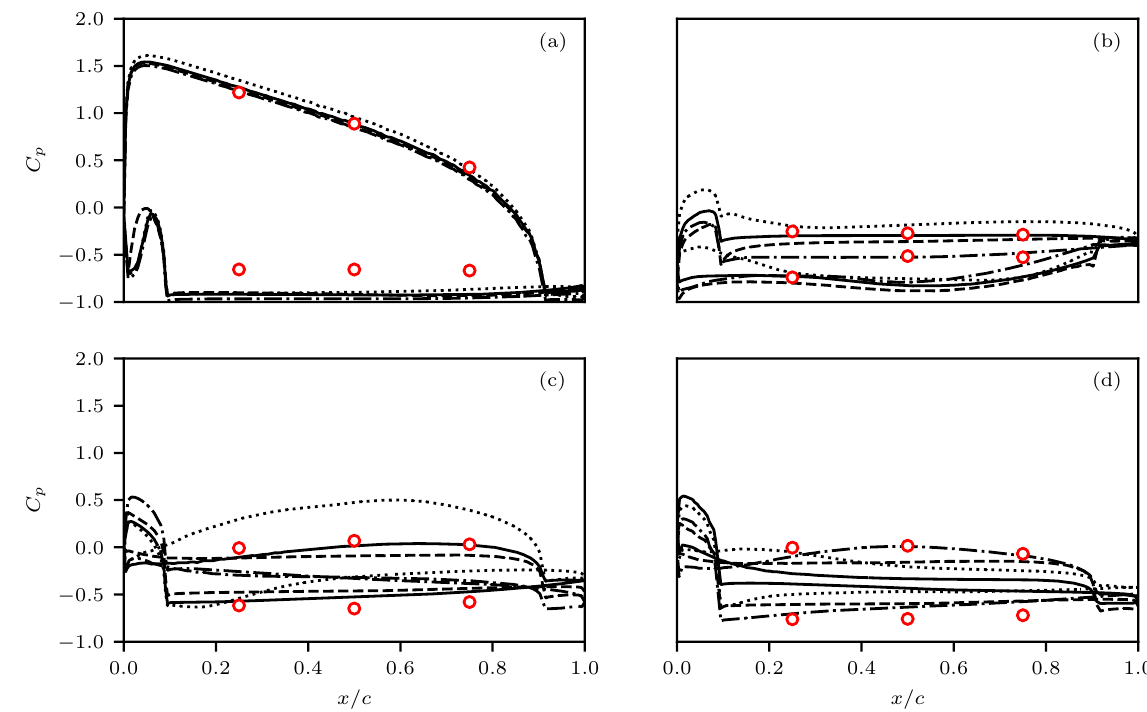
Figure 5. Pressure coefficient C p distribution for ( a ) 1st panel, ( b ) 2nd panel, ( c ) 3rd panel, and ( d ) 4th panel. Lines refers to numerical results for the different turbulent models: k - (cid:101) ( ); SST k - ω ( ); transition SST ( ); and RSM ( ). Experimental measurements are shown as (